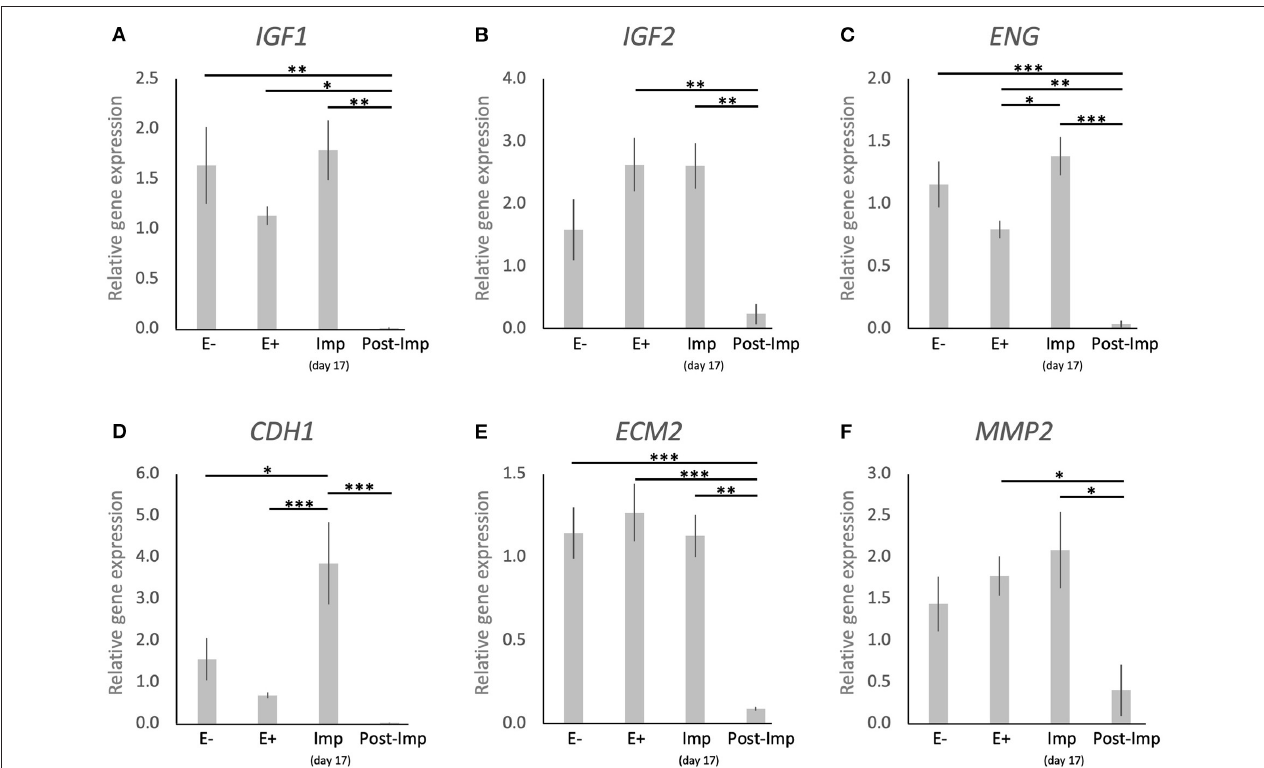
FIGURE 5 | Relative gene expression of selected factors involved in tissue remodeling in the canine uterus. (A–F) Relative gene expression as determined by semi-quantitative real time (TaqMan) PCR (mean ± SEM). One-way ANOVA was applied, revealing: P = 0.0007 for IGF1 , P = 0.0032 for IGF2 , P < 0.0001 for ENG , P = 0.0002 for CDH1 , P < 0.0001 for ECM2 , P = 0.0174 for MM2 . In the case of P < 0.05, this was followed by a Tukey-Kramer multiple comparisons post-test. Bars with asterisks differ at: * P < 0.05, ** P < 0.01, *** P <